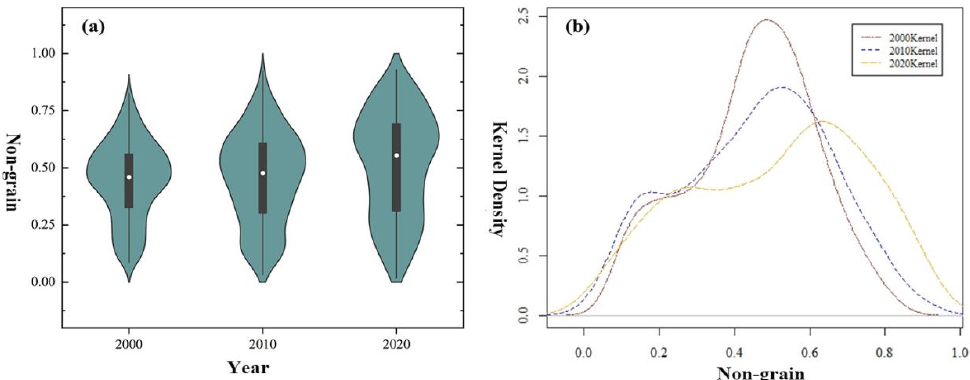
Figure 3. The evolution of NGPCL in China from 2000 to 2020. ( a ) The degree of NGPCL in 2000, 2010, and 2020. ( b ) The kernel density curve of NGPCL in 2000, 2010, and